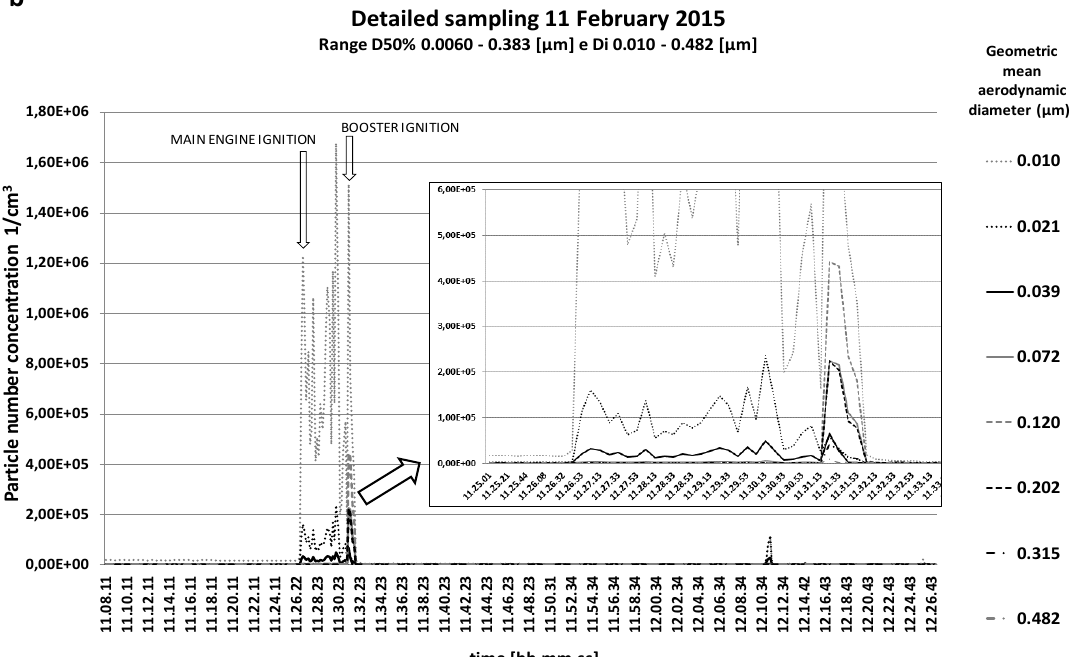
Figure 2. Particle count during the target drone launch ( a ). The lower picture shows ( b ) a representative time plot. Aerodynamic diameter range = D50%. Geometric mean aerodynamic diameter range = Di.